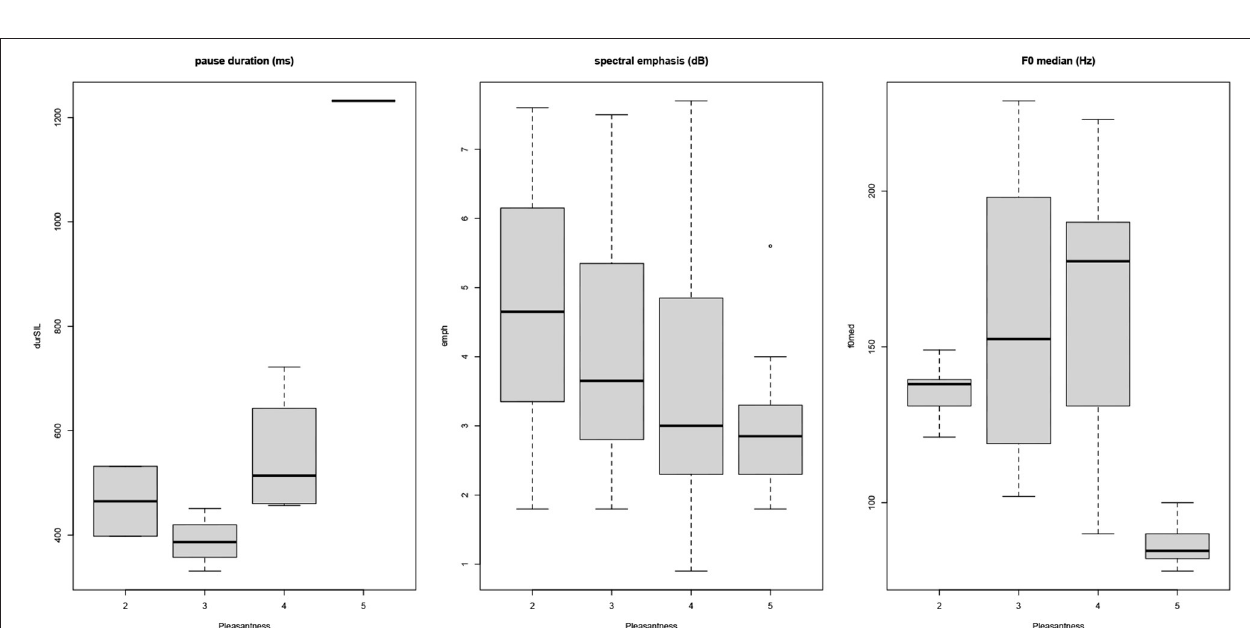
FIGURE 3 | Boxplots of the three acoustic parameters that predict pleasantness for the EP dataset.